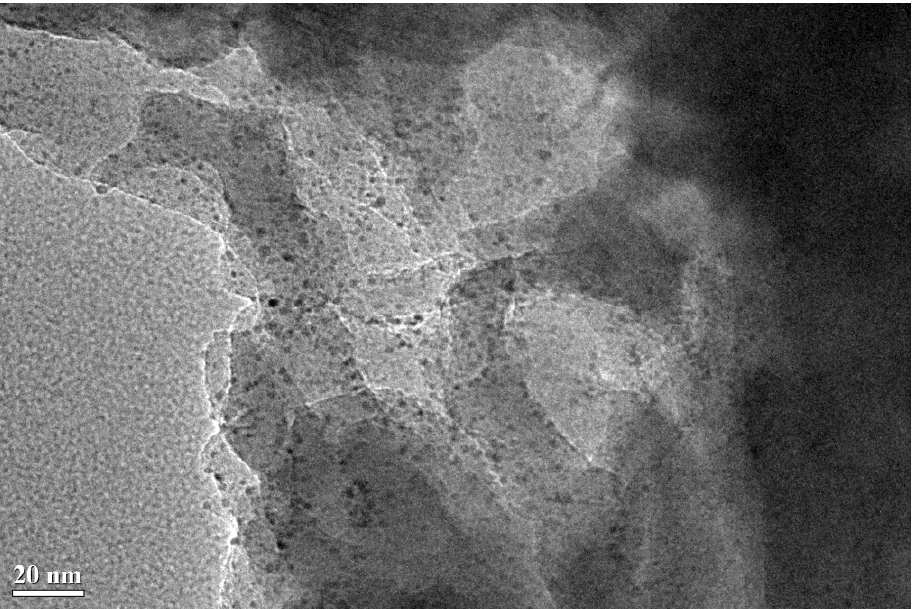
Figure 4. TEM image of spent Pt/Al-P-O (calcined at 500 °C, pretreated in 4% H 2 at 300 °C, and tested in CO